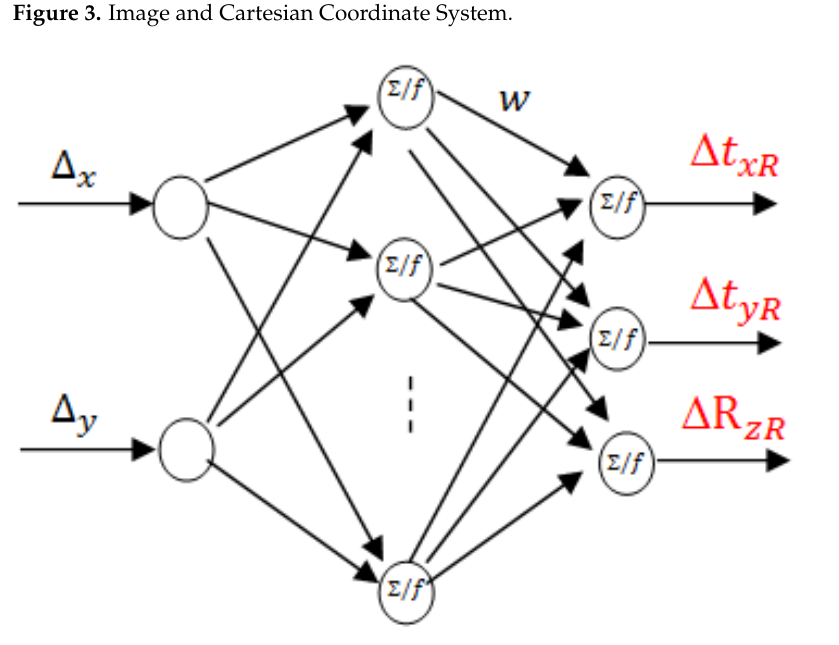
Figure 4. Neural Network Architecture.